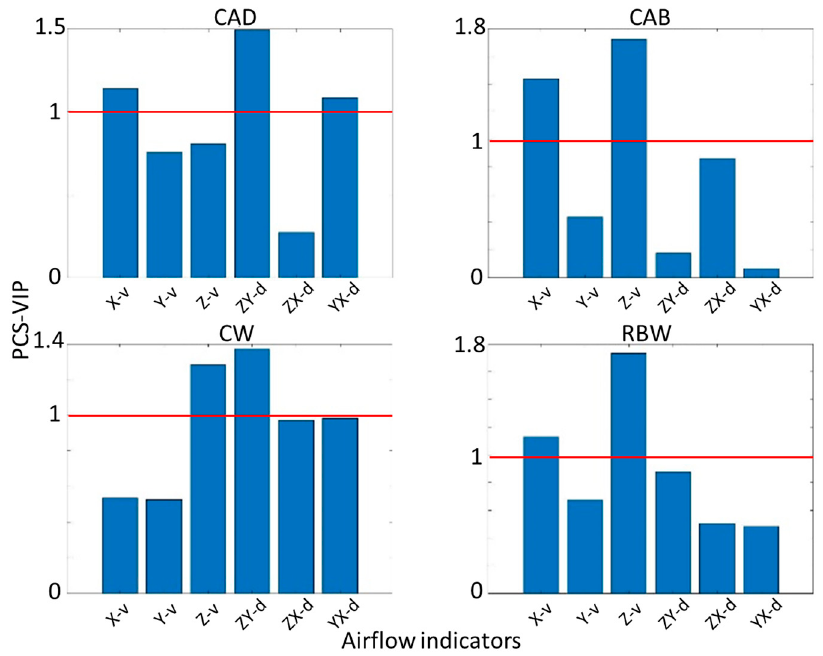
Figure 6. PLS-VIP analysis results between the airflow indicators and the deposit indicators of OSP1–OSP4. The red line indicates that the PLS-VIP = 1, PLS-VIP > 1 indicates a significant effect [40]. The red line marks the position where the PLS-VIP value is